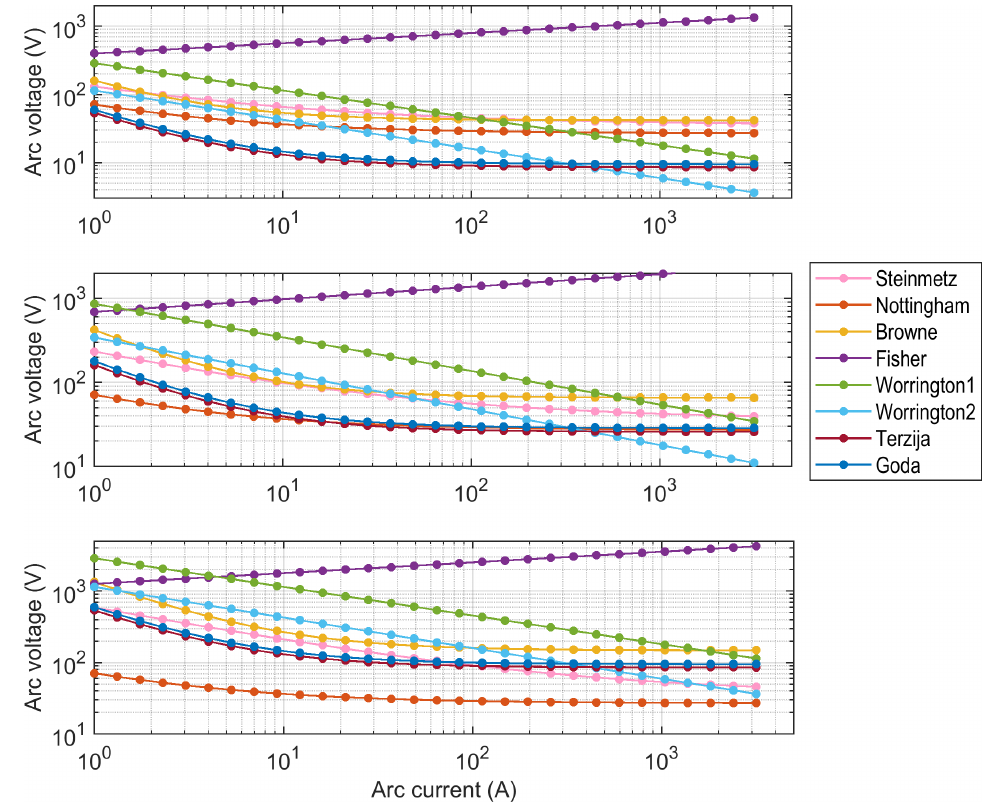
Figure 3. Overview of the static V-I characteristics reviewed in Section 2.2.1: inter-electrode gap values are d = 10mm ( top ), d = 30mm ( middle ) and d = 100mm ( bottom ). The names of the first authors are used for the above expressions with obvious